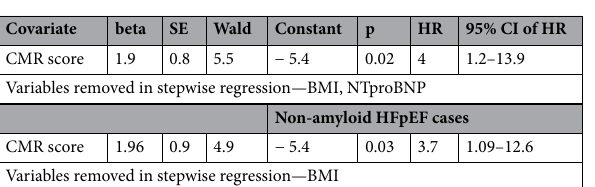
Figure 4. Multiparametric CMR score in HFpEF. ( A ) Kaplan–Meier survival curves. ( B ) The relative difference of area under the curve (AUC) between the CMR model and the clinical characteristics. The CMR model demonstrated significant increase in area under the curve.